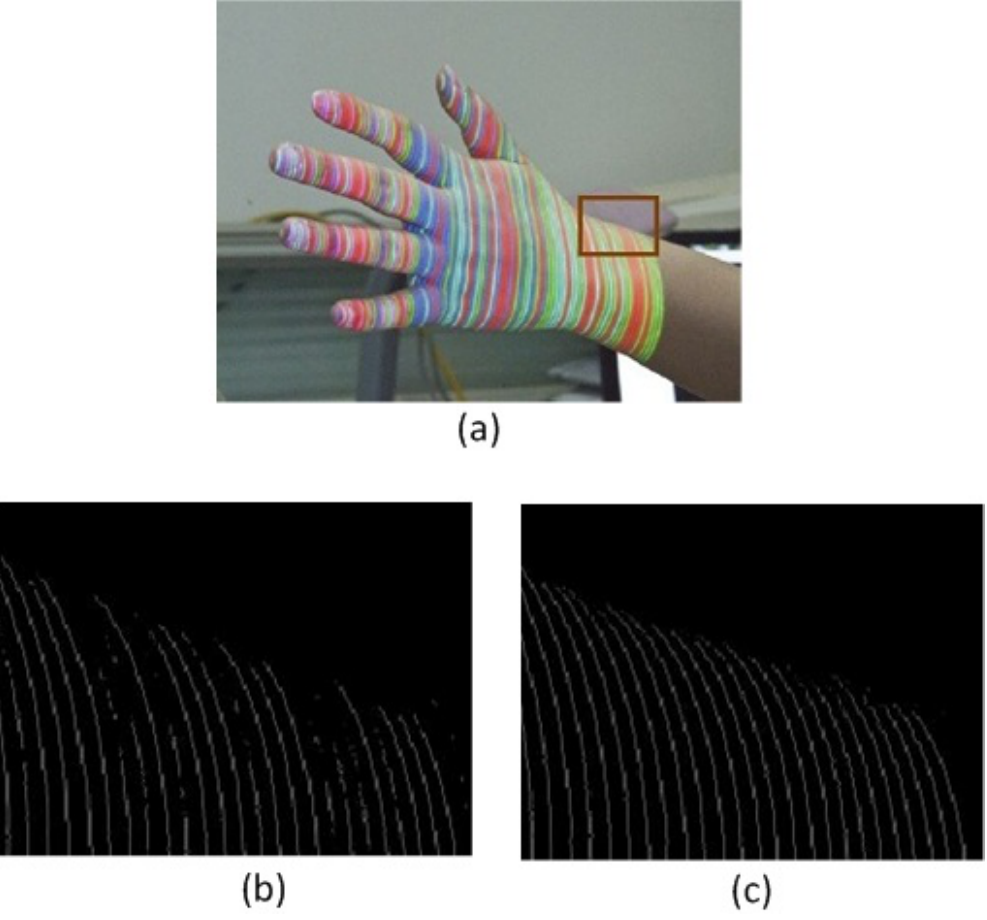
Figure 5. A comparison of stripe segmentation result. ( a ) captured source image; ( b ) stripe segmentation result using local adaptive thresholding method; ( c ) stripe segmentation result using